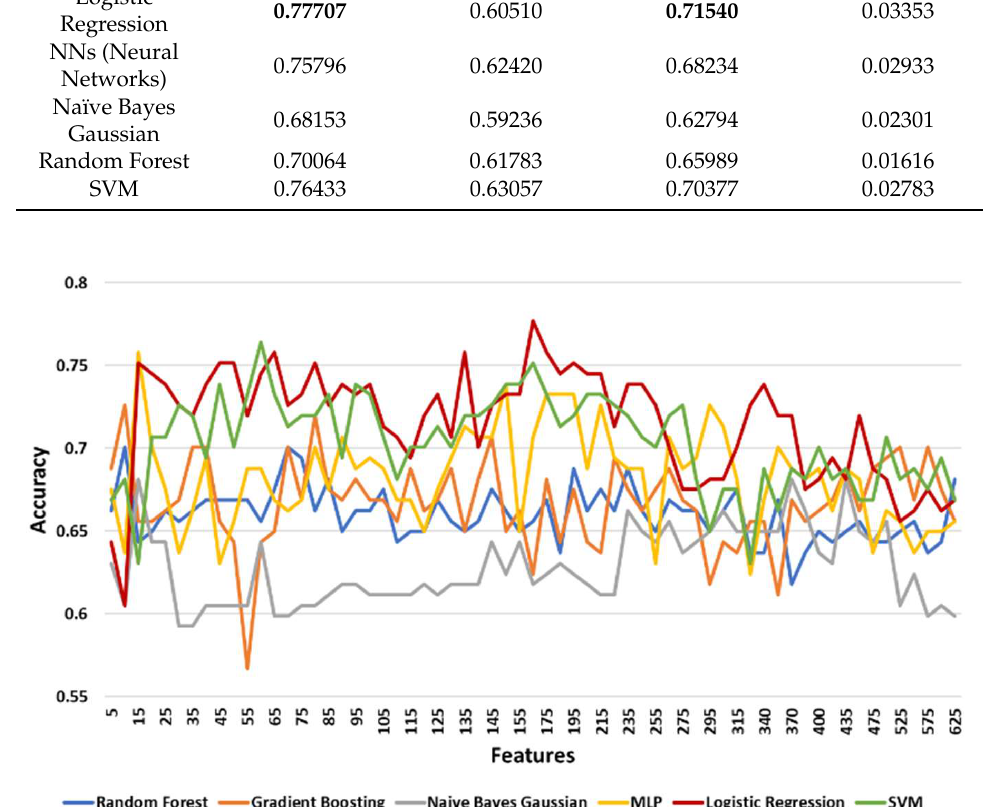
Figure 5. The accuracy of models over test set for increasing number of features for the left leg. Results are shown with a step size of 5 (two features added at each step).